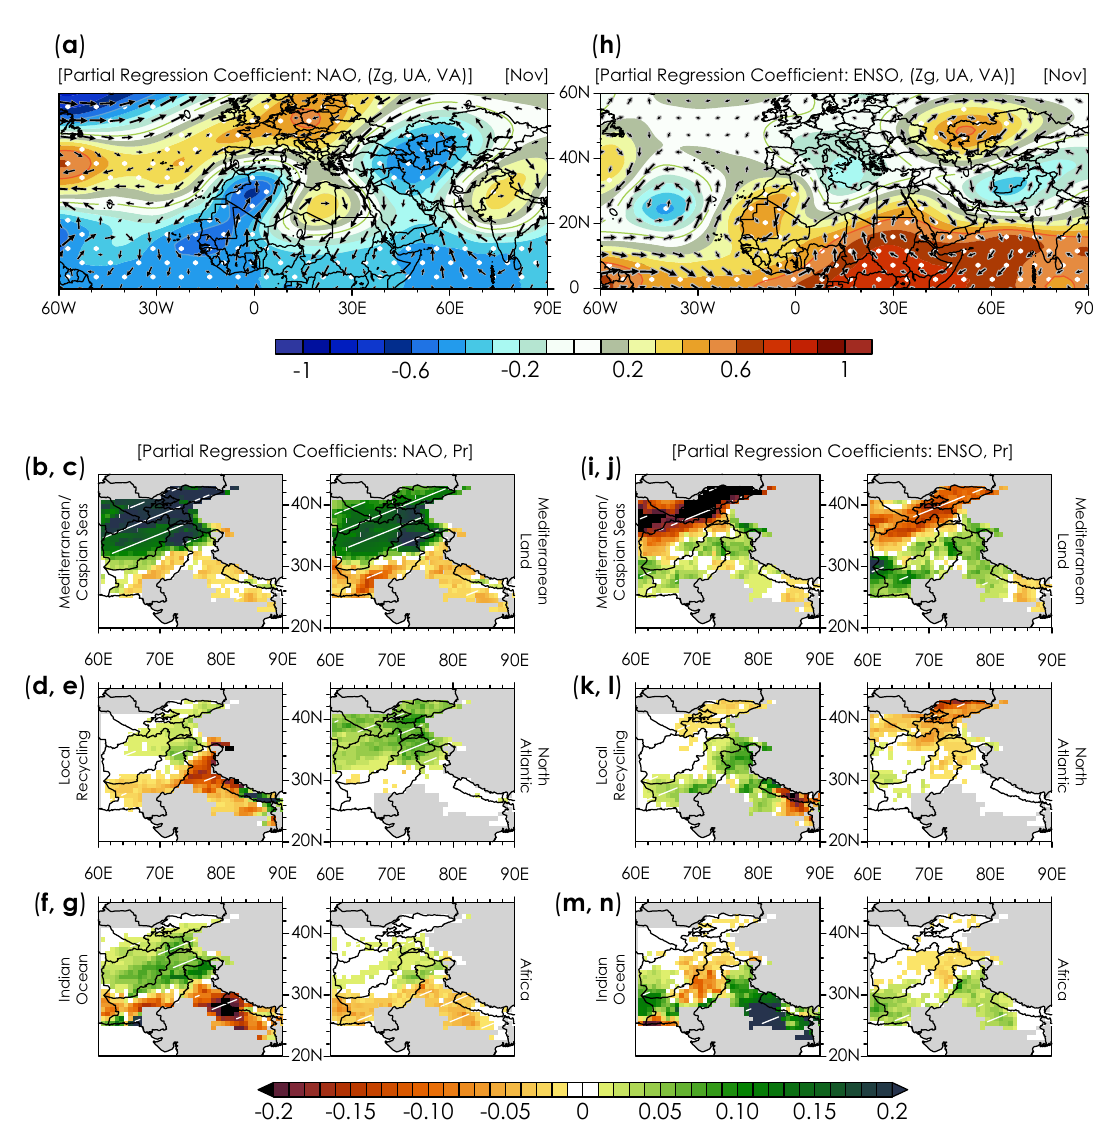
Fig. 7 Standardized partial regression coef fi cients associated with the NAO and ENSO in the multi-linear regression models. Standardized partial regression coef fi cients of 200 mb geopotential height, zonal and meridional winds ( a ), and regionally recycled precipitation ( b – g ) on the NAO index in November. Six selected evaporative source regions exhibit the most prominent statistically signi fi cant relationship. ( h – n ) Same as in ( a – g ) but for ENSO in February. Standardization of regionally recycled precipitation is with respect to the total recycled precipitation. Stippling represents statistical signi fi cance at a 90% con fi dence